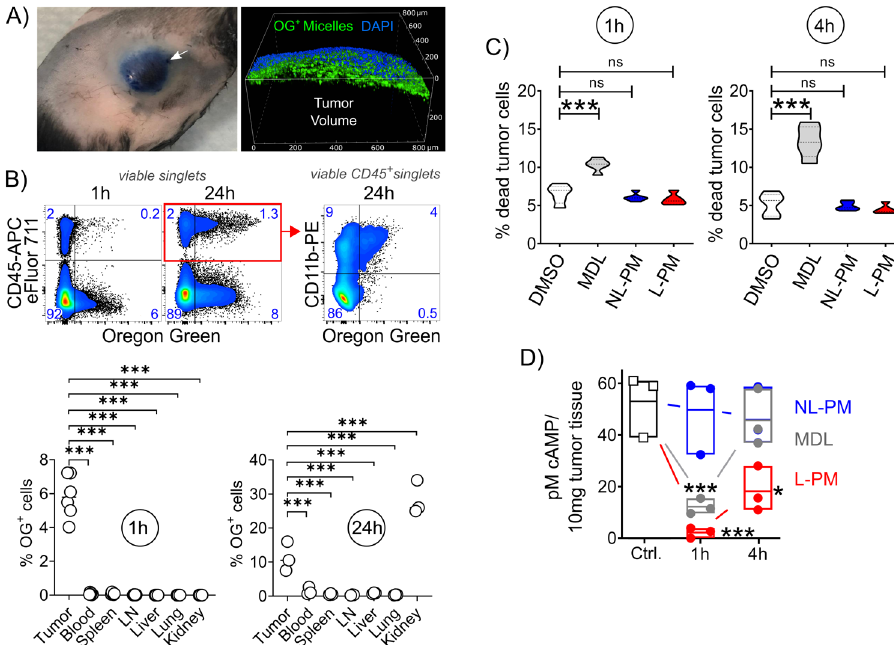
Fig. 2 Effect and distribution of peritumorally injected MDL-loaded polymer micelles. A Peritumoral injection. Left: Image of a mouse with B16 melanoma after peritumoral injection of Evans Blue, injection site indicated by the arrow, fur removed for better visibility; right: Confocal microscopic image of the tumor margin after peritumoral injection of Oregon Green (OG)-labeled micelles. B Frequency of OG-labeled cells in different organs 1 and 24 h after peritumoral injection of OG-labeled L-PM micelles at day 14 B16-OVA melanomas. Representative fl ow cytometric plots, numbers represent cell frequencies in gates. LN lymph nodes ( n = 6 (1 h) and n = 3 (24 h) per organ, all comparisons *** P < 0.001 (parametric one-way ANOVA, with Holm – Š ídák ’ s multiple comparisons test, alpha = 0.05, 0.95 con fi dence interval). C Micelles (NL-PM, blue; L-PM, red), free inhibitor (MDL, gray),